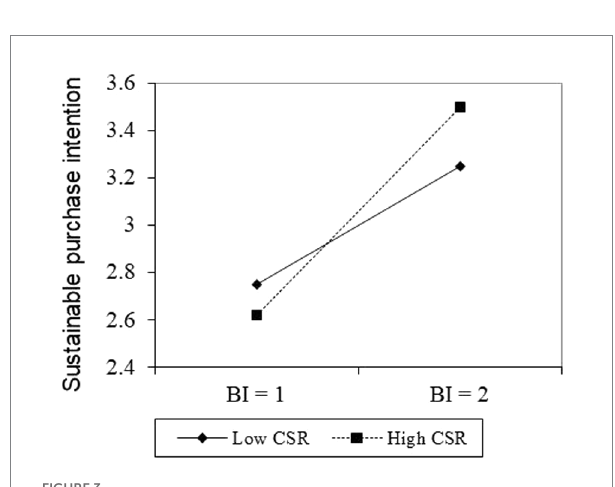
FIGURE 3 Moderating effects of corporate social responsibility on the relationship between brand image and sustainable purchase